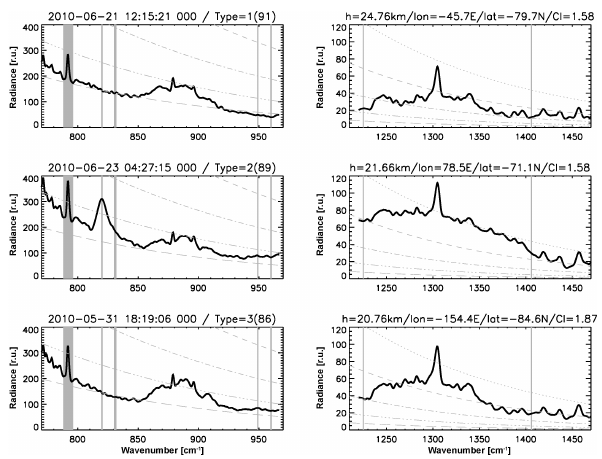
Figure 1. Examples of MIPAS radiance spectra in radiance units (1r.u. = 1nW/(cm 2 srcm − 1 )) in the two main wavelength re- gions of interest. Spectra are classified into ice (top), NAT (mid- dle), and STS (bottom) with high confidence in classification ( P type = 91/89/86%, see Sect. 3.3). Superimposed grey bars are the selected wavelength regions for the classification scheme. The spectral resolution is degraded to ∼ 1.2cm − 1 with a sampling of 0.35cm − 1 . Planck functions for 140 to 180K in 10K steps are su- perimposed in grey dash/dotted